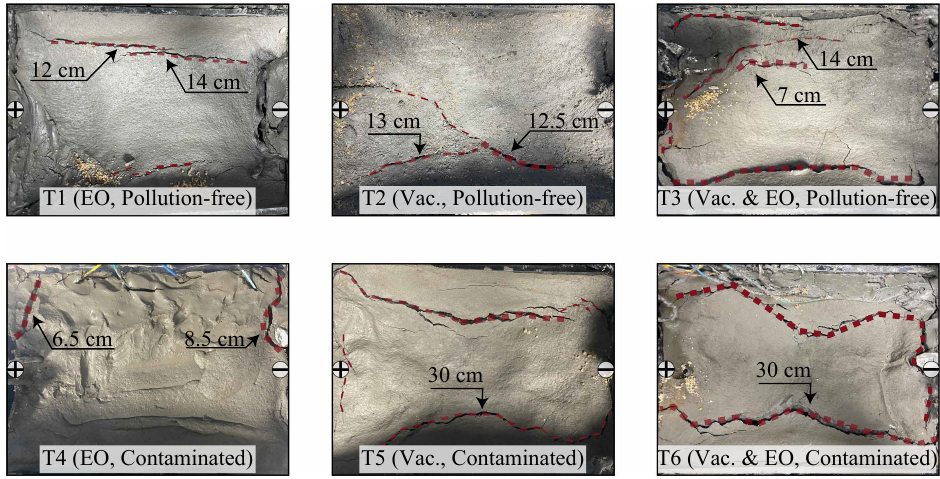
Figure 8. Distribution law of soil